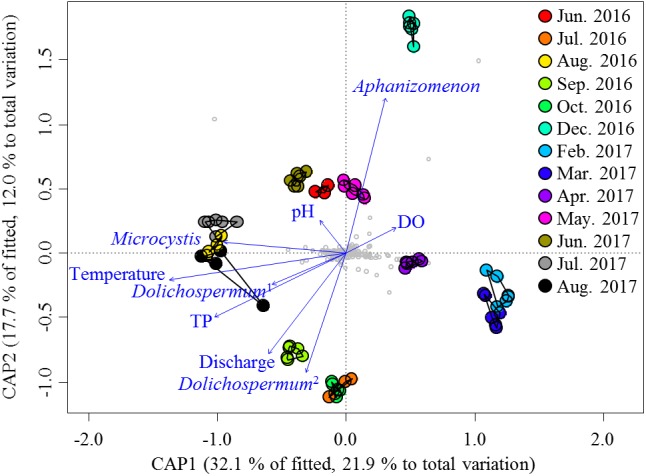
db-RDA ordinations of the non-cyanobacterial community based on the Bray–Curtis distance. Vectors indicate the direction of the significant parameter (P < 0.001) effect in the ordination plot. Small gray circles represent OTUs. Dolichospermum1 indicates OTU00013, and Dolichospermum2 indicates OTU00035.